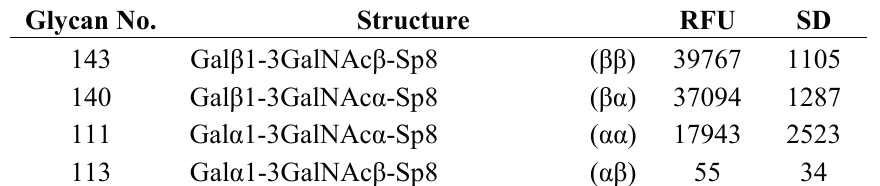
Table 3. Binding affinity of SSR1 towards different anomeric forms of TF disaccharides. Glycan